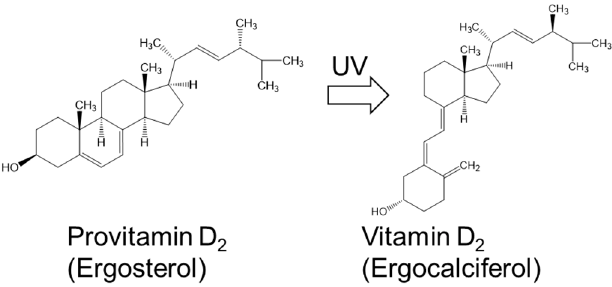
Figure 1. Structures of provitamin D 2 and vitamin D 2 found in commercially available Chlorella products. Serum homocysteine (Hcy) is an established biomarker of cardiovascular disease in humans [45,46]. Hcy is a non-protein forming amino acid (Figure 2) produced as an intermediate compound of methionine metabolism and is further metabolized to cystathionine via cystathionine β -synthetase, a vitamin B 6 -dependent enzyme [46]. Alternatively, Hcy can be remethylated back to methionine by